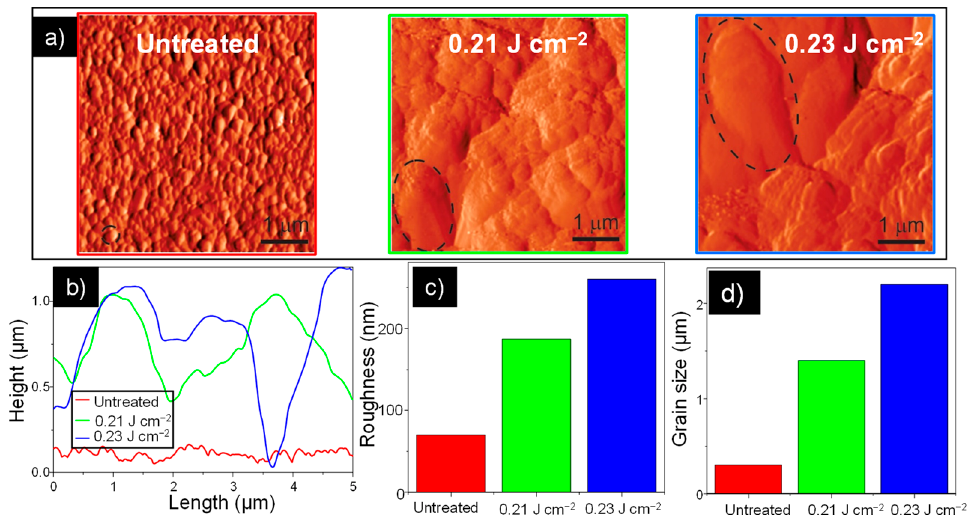
Figure 3. ( a ) AFM characterization of the untreated sample and samples treated at 0.21 and 0.23 J cm –2 . Inset: Corresponding 3D morphologies. ( b ) Surface profile from AFM analysis of the untreated and laser treated samples. ( c ) Roughness measurement of the investigated screen-printed films. ( d ) Grain size measurement of the investigated screen-printed films.